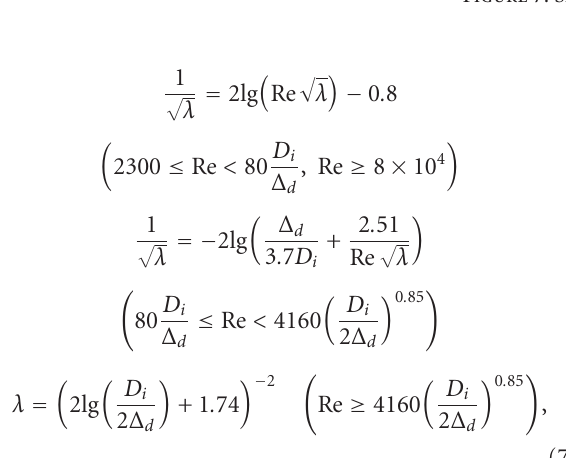
Figure 7: Snapshot of the